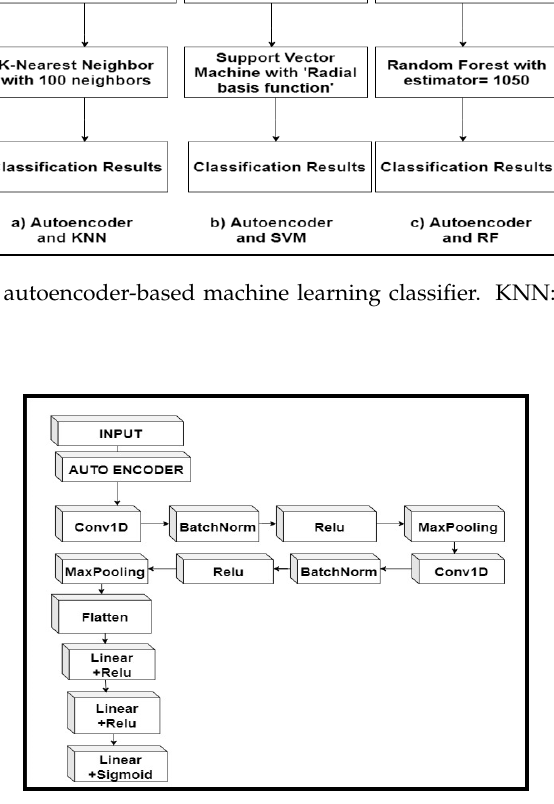
Figure 7. The hybrid autoencoder-based machine learning classifier. KNN: K-nearest neighbour; RF: random forest.